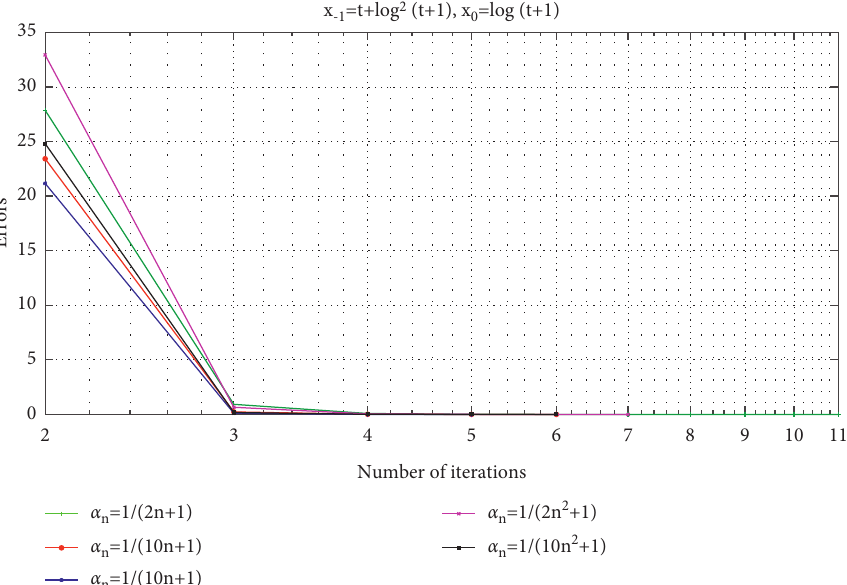
Figure 9: The Cauchy error plotting number of iterations for different parameters α